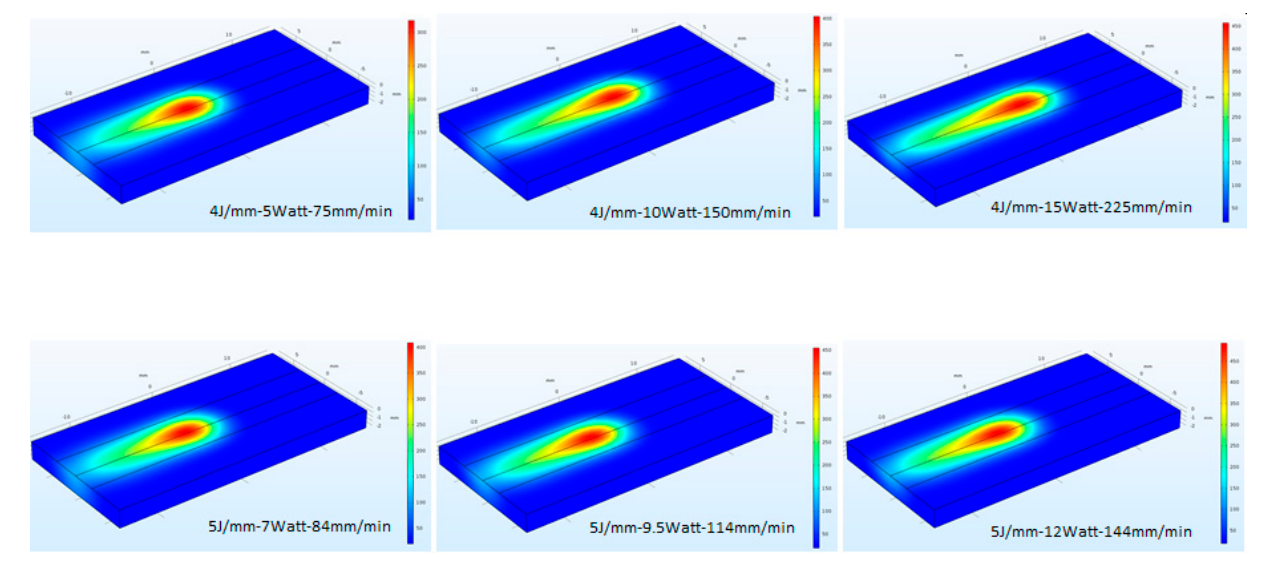
Figure 7. Simulation results for Table 1 (max. temp 500 °C).